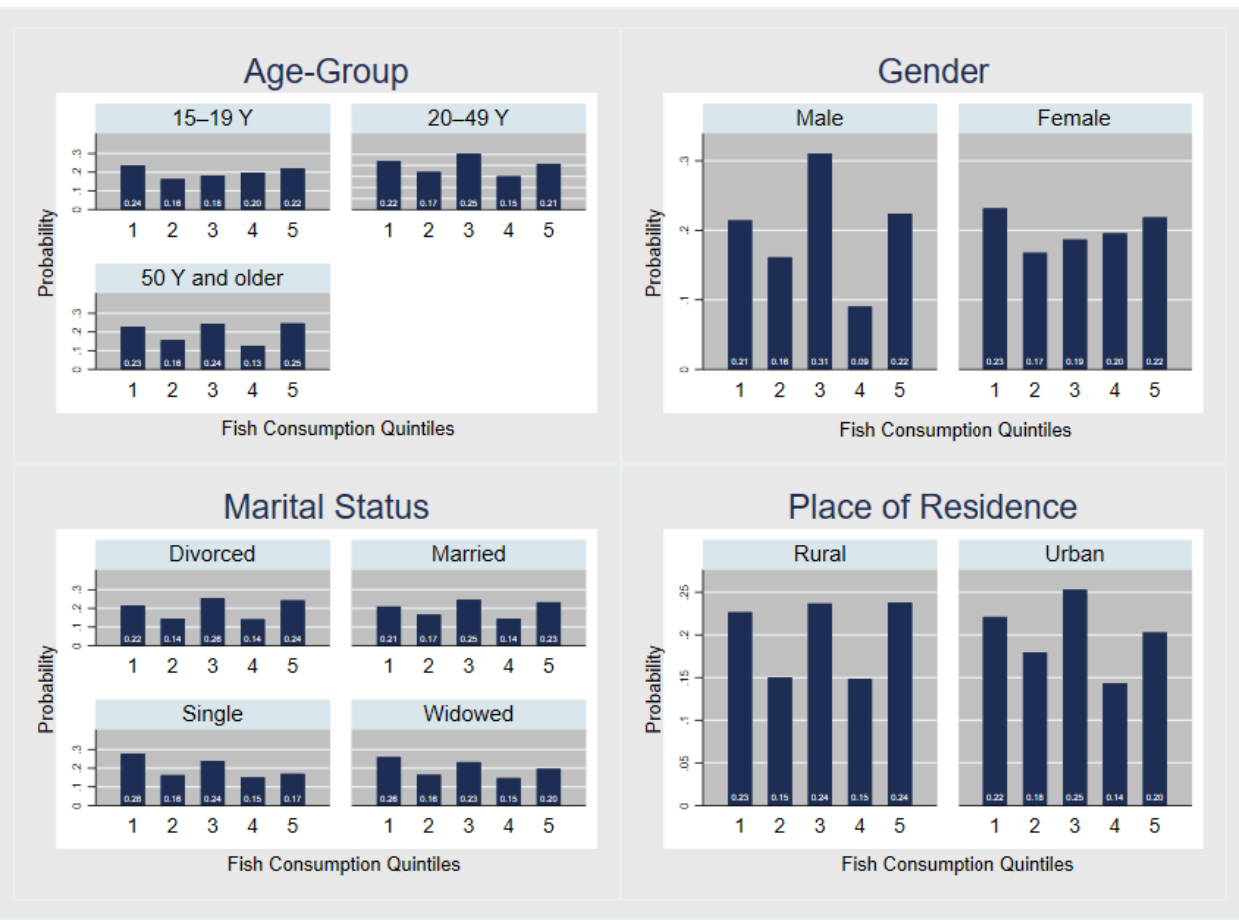
Figure 2. Bar charts showing the predicted probabilities of being in each fish consumption quintile by age-group, gender, marital status, and place of residence.